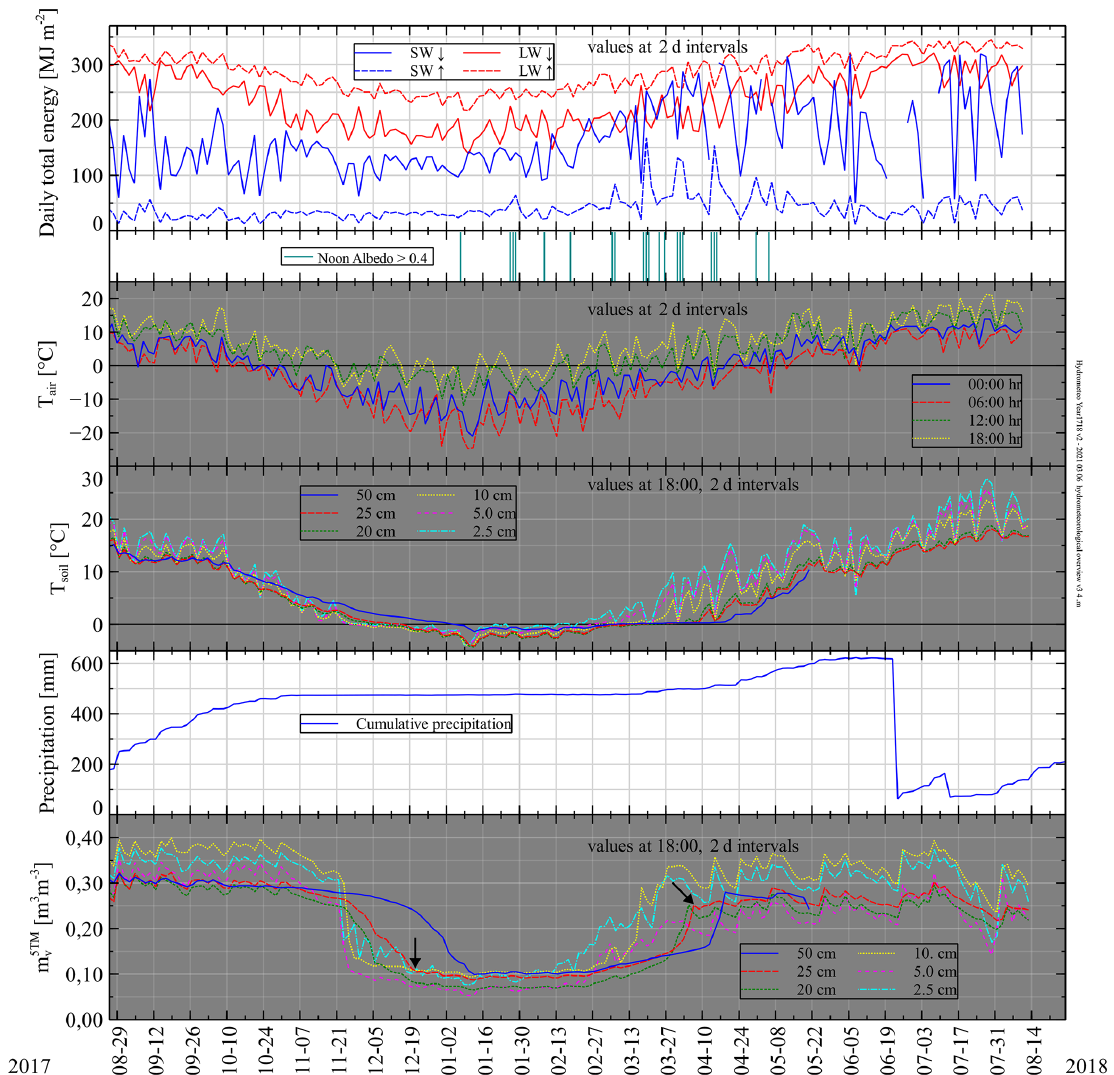
Figure A2. Overview of hydrometeorological quantities measured at the Maqu site over the period 26 August 2017–26 August 2018. From top to bottom: daily total sum of down- and upward hemispherical energy (MJm − 2 ) for short (285–3000nm) and long (4500– 40000nm) wavelengths at 2d intervals, days with snowfall (identified from noon albedo), air temperatures ( ◦ C) at four times during the day at 2d intervals, soil temperatures T soil ( ◦ C) for different depths at 2d intervals, cumulative precipitationmm, and volumetric soil mois- ture m 5TM v m 3 m − 3 for different depths at 2d intervals. Arrows indicate freeze/thaw of soil at 25cm. Spatial average volumetric soil moisture M v is estimated as M v = m 5TM v ± 0 . 04m 3 m − 3